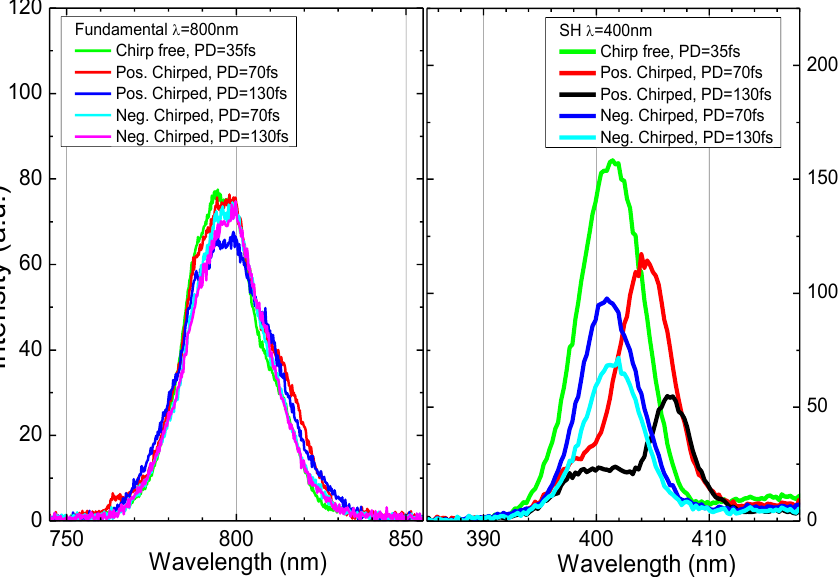
Figure 2. The fundamental (( left ) panel) and second-harmonic (( right ) panel) spectra of PP. Figure 3 shows three groups of temporal shapes of chirp-free and chirped 70- and 130-fs pulses determined using the relations from Ref. [25].